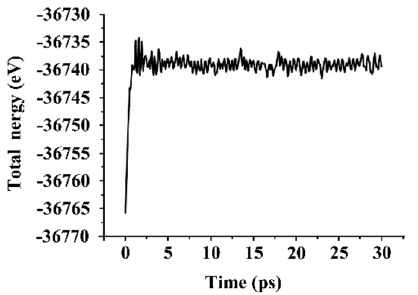
Figure 4. Relationship between total energy and relaxation time of grapheme.